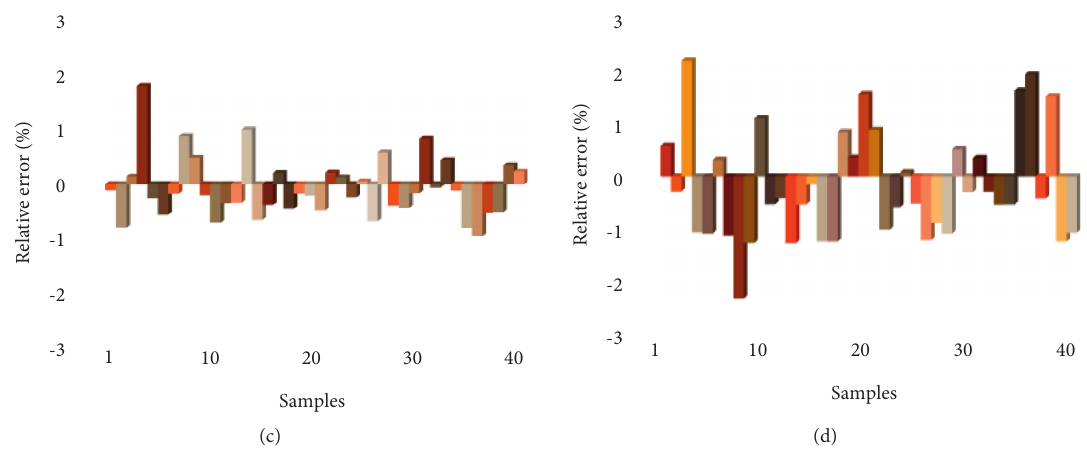
Figure 7: Relative error: (a) University 1; (b) University 2; (c) University 3; (d) University